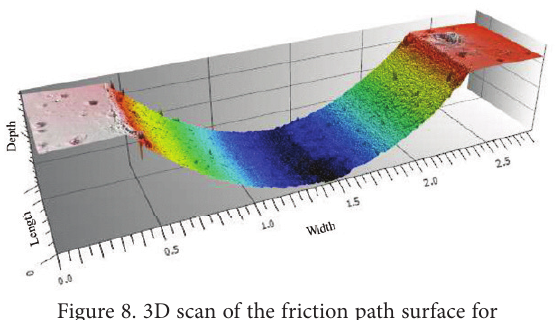
Figure 8. 3D scan of the friction path surface for